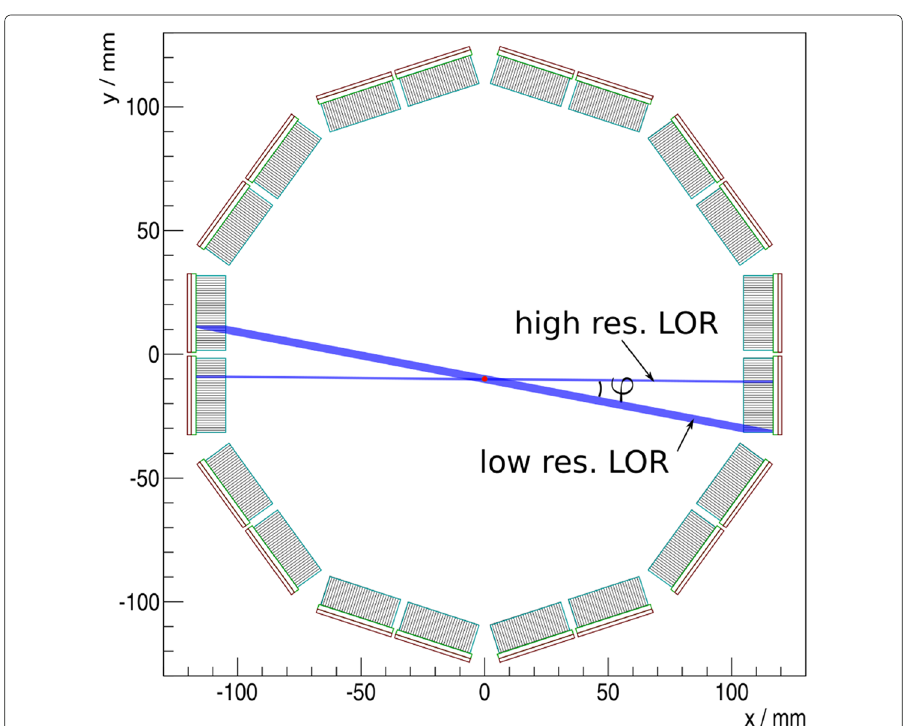
Fig. 1 Ring geometry that was used for the simulations and the measurement. The blue bands show the parallax error of LORs, which increases approximately proportional to the angle ϕ to the normal of the block